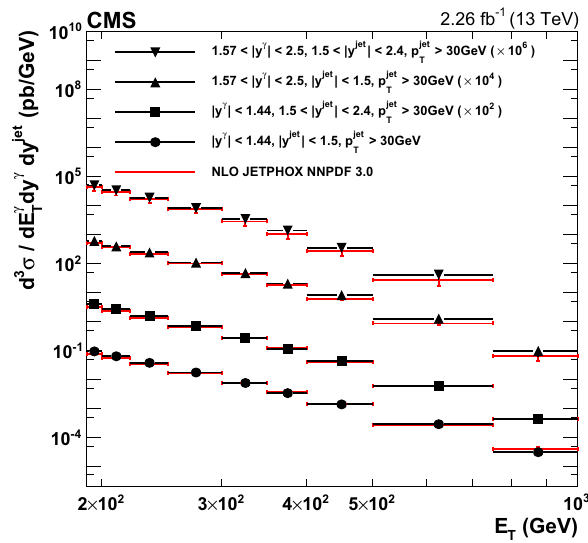
Fig. 5 Differential cross sections for photon+jet production in two photon rapidity bins, | y γ | < 1 . 44 and 1 . 57 < | y γ | < 2 . 5, and two jet rapidity bins, | y jet | < 1 . 5 and 1 . 5 < | y jet | < 2 . 4. The points show the measured values with their total uncertainties, and the lines show the NLO jetphox predictions with the NNPDF3.0 PDF set